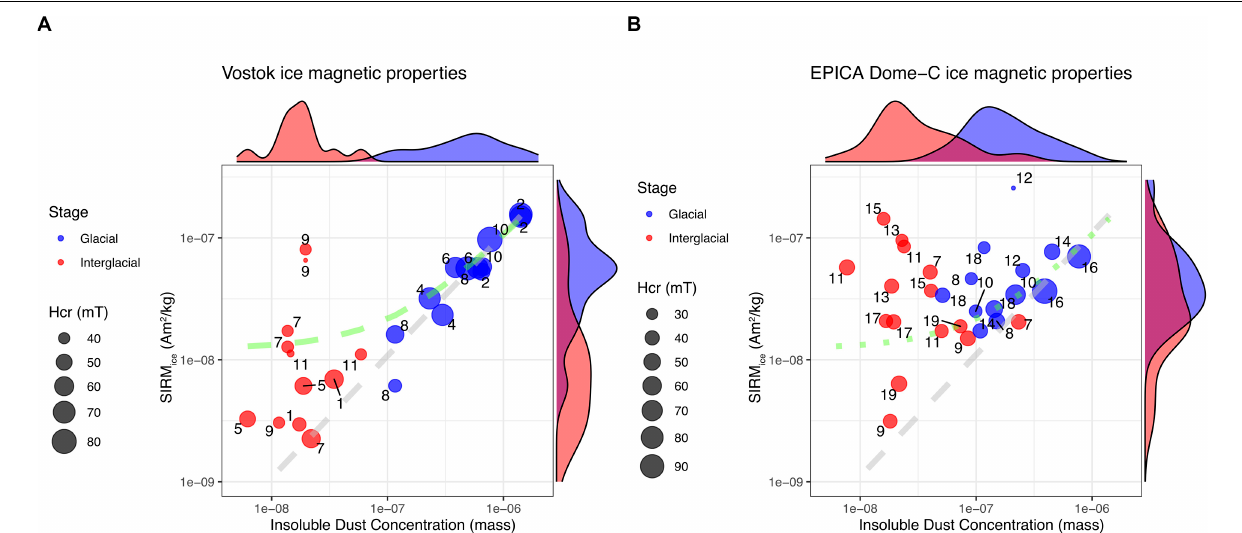
FIGURE 4 | Log-log diagram of IDC and SIRM ice of the EDC and VK datasets. Samples are grouped by color in glacial and interglacial stages with numbers indicating the isotopic stage (MIS) of each sample, symbols size is proportional to H cr . Estimated distribution densities are shown in the marginal plots. (A) In VK samples the distributions of glacial and interglacial SIRM ice are distinct and most of the samples do not deviate significantly from a linear relationship between IDC and SIRM ice . The best-fit lines (not rectilinear in the log-log diagram) represents the following models: SIRM ice = 0.108 × IDC + e i (gray) and SIRM ice = 0.0935 × IDC + 1.23 × 10 − 8 + e i (green) where e i are random variables representing the deviations of the data from the best-fit line. (B) Compared to VK, EDC samples shows significant differences in the distribution of SIRM ice . EDC ice samples from interglacial stages are much more magnetic than VK and the same linear relationship found in VK (here reported for comparison) is not maintained.